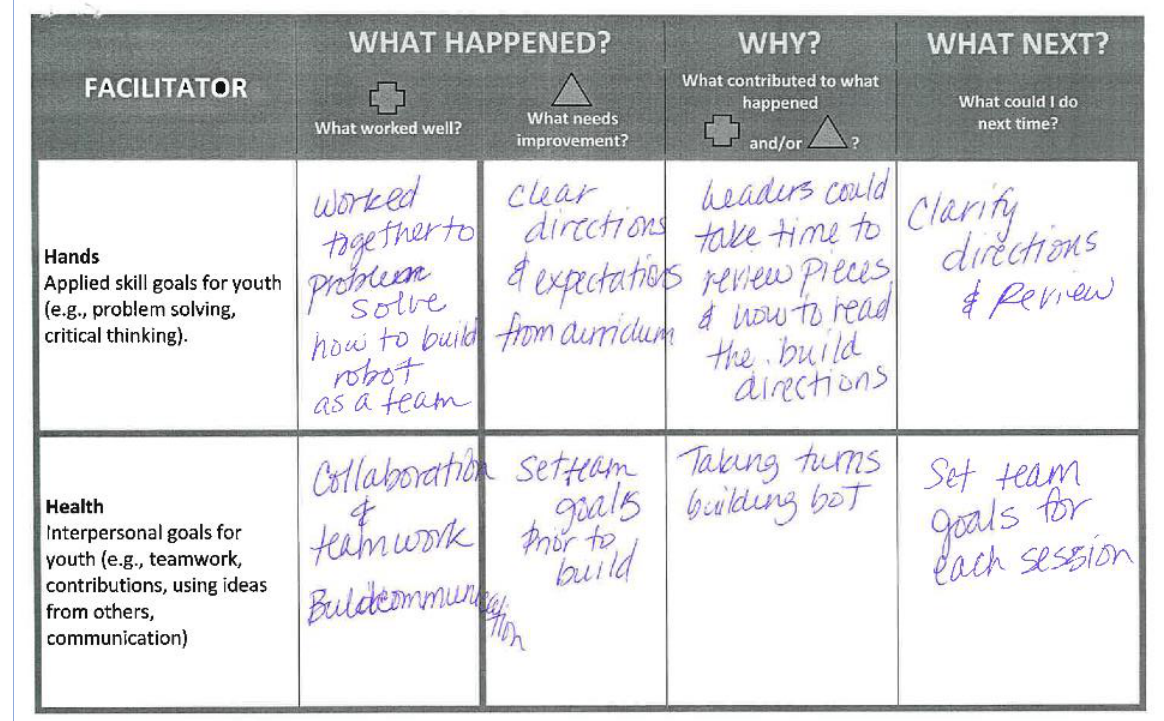
Figure B2. Example Educator Reflection Tool From Robotics Curriculum